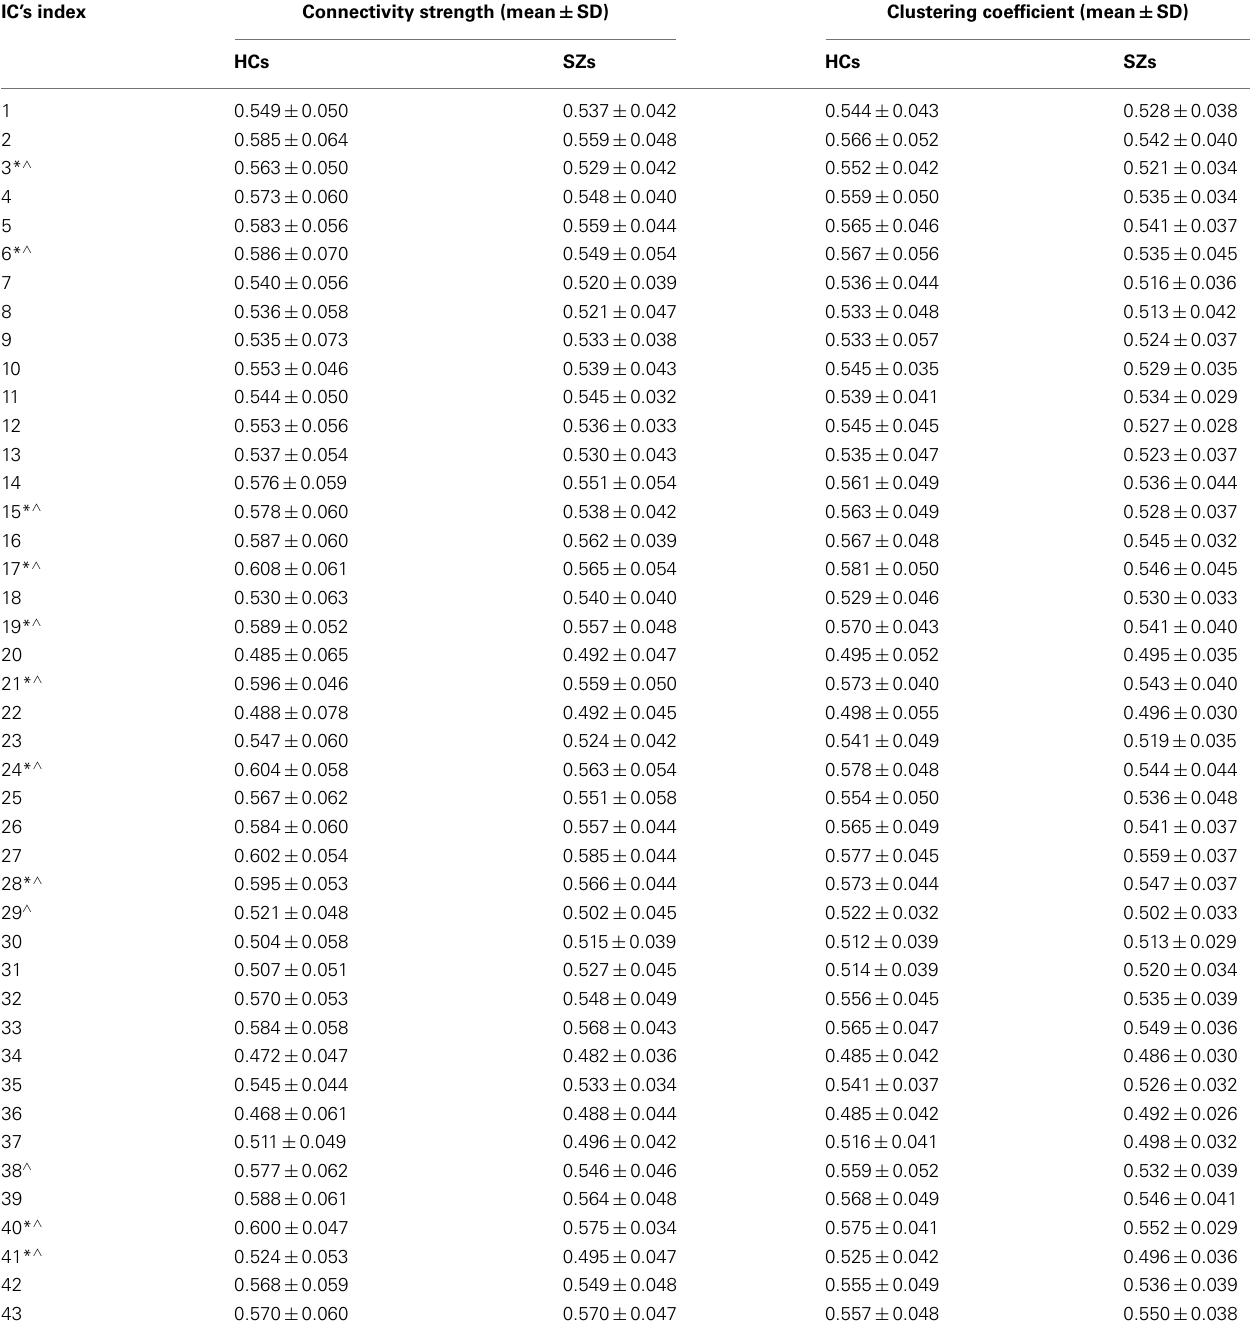
TableA1 | Connectivity strength and clustering coefficient of each individual node in HCs and